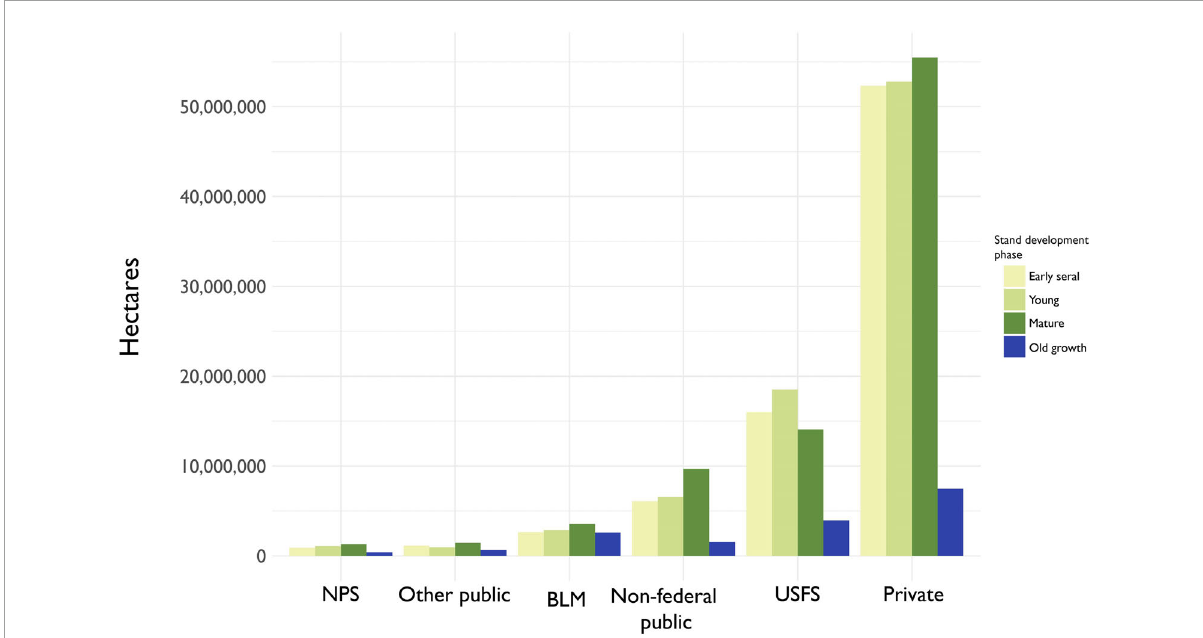
FIGURE6 Estimates of forested area by ownership groups and stand development phase. “NPS”, National Park Service; “Other federal”, Fish and Wildlife Service, Department of Defense, Department of Energy, and other federal agencies; “BLM”, Bureau of Land Management; “Non-federal public”, state/local governments or other non-federal public institutions; “USFS”, United States Forest Service; “Private”, undifferentiated private and Native American reservation